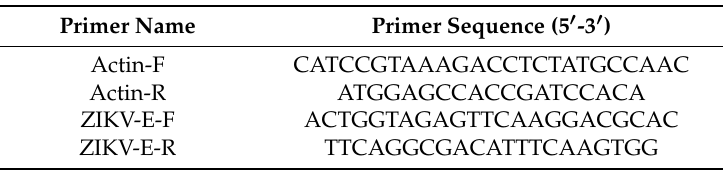
Table 1. List of primers for real-time quantitative